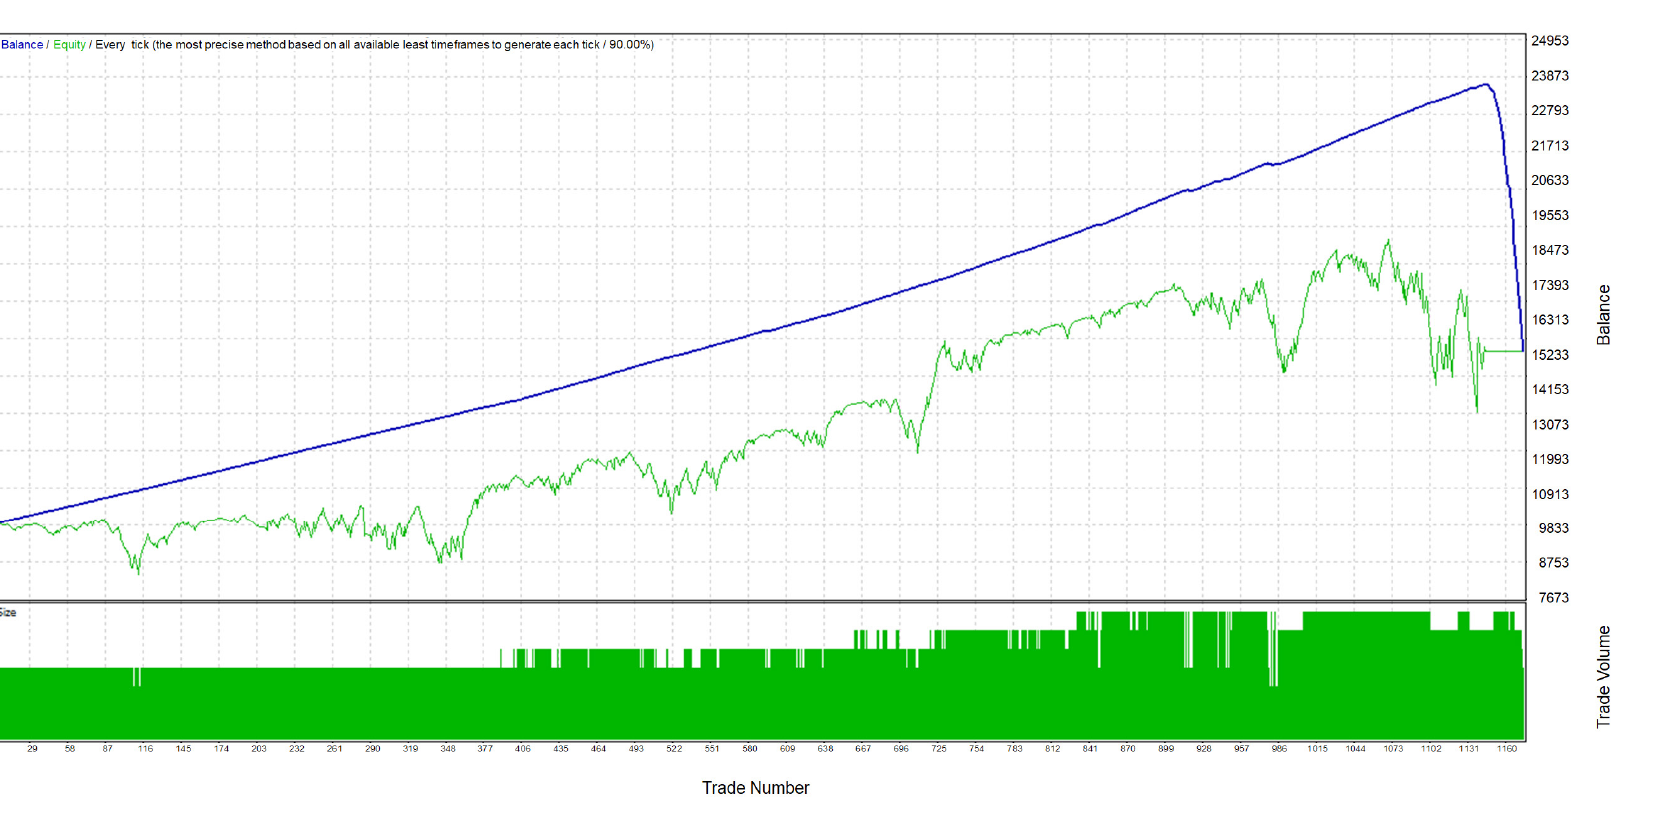
Figure 9. Sample Positive Growth Path of a Grid Trader in MT4